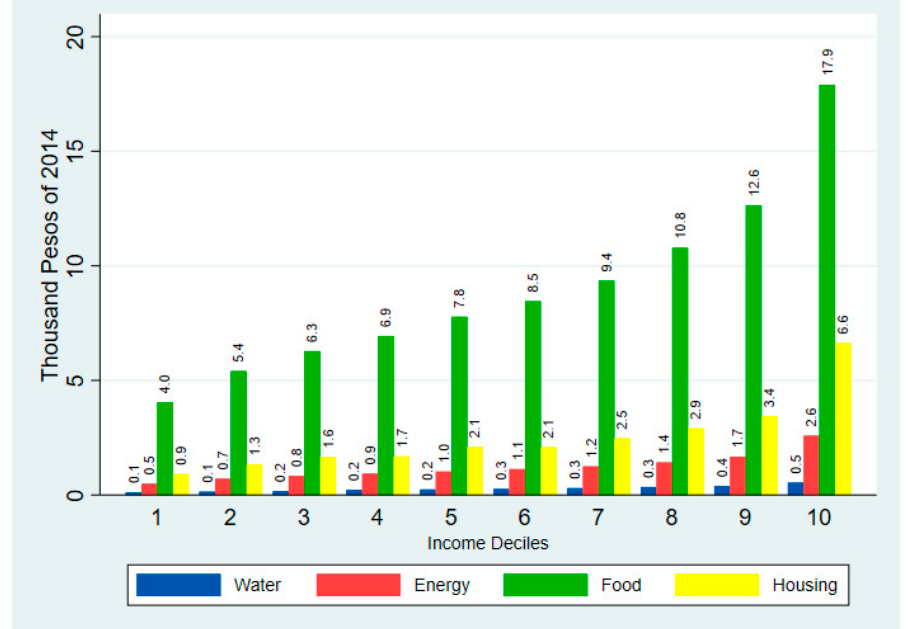
Figure 6. Household expenditure, selected categories. Source: Authors’ elaboration using data from ENIGH [25].